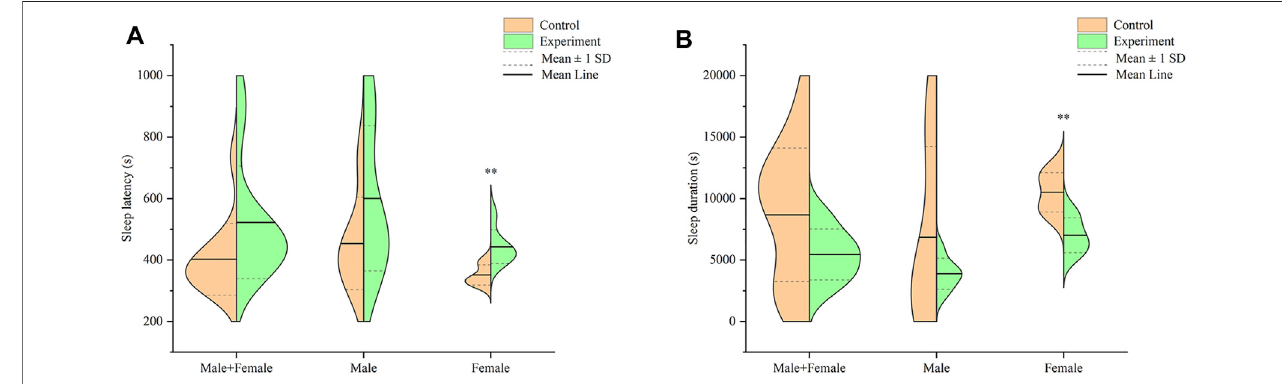
FIGURE 6| Effect ofHp-associated chronic gastritis on suprathreshold dose of sodium pentobarbital-induced sleep in mice. (A) Splitviolin plot showing the effect of Hp-associated chronic gastritis on sleep latency; (B) Split violin plot showing the effect of Hp-associated chronic gastritis on sleep duration. ** p < .01 versus control.